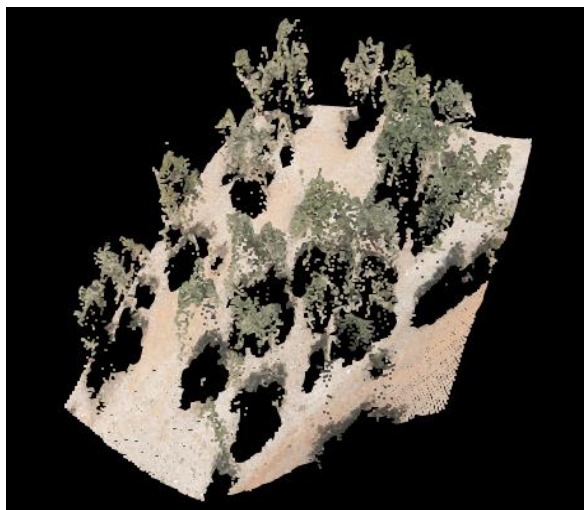
Figure 1: point clouds extracted from aerial images .